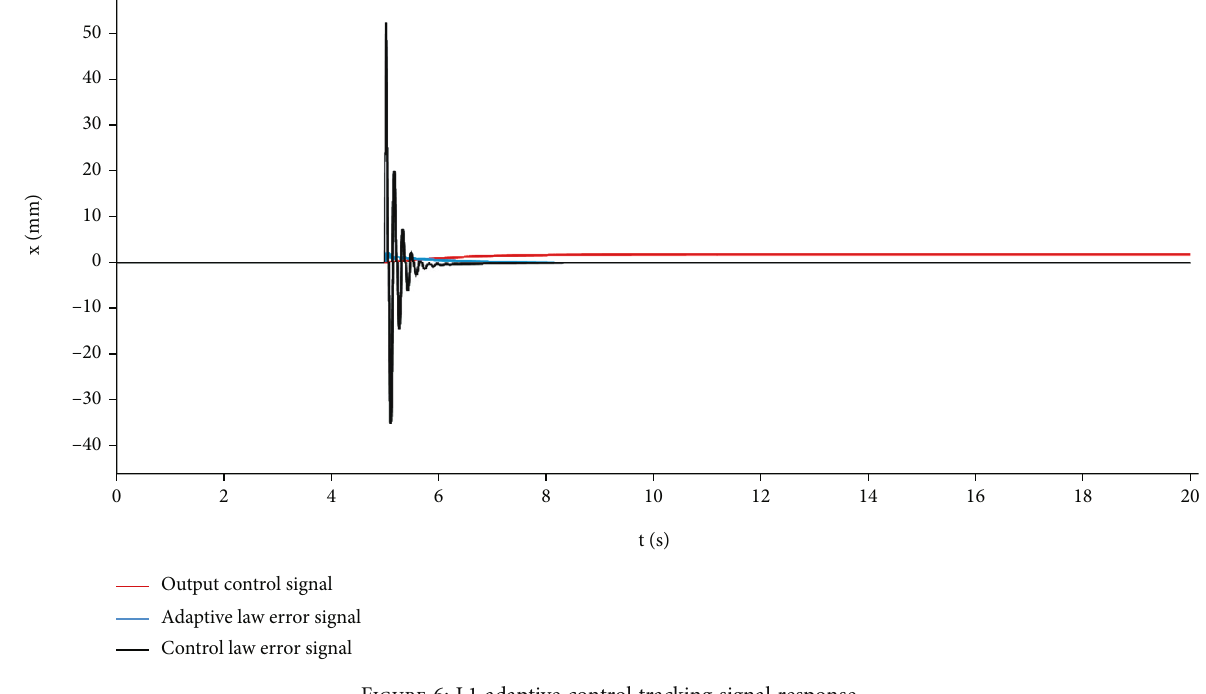
Figure 6: L1 adaptive control tracking signal response.